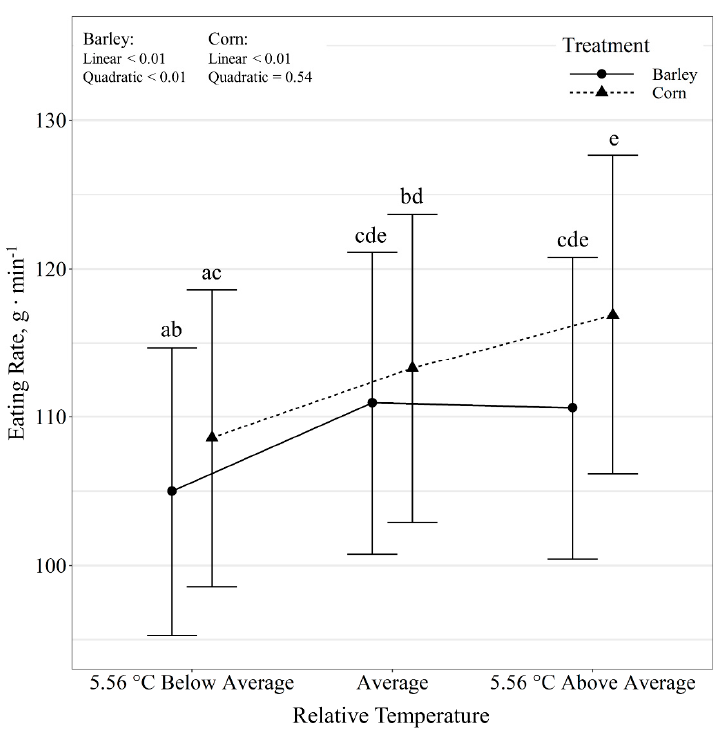
Figure 4. Influence of relative temperature change × diet ( p = 0.04) on eating rate (expressed as g min − 1 ) by beef steers consuming either barley or corn-based feedlot diets at the Northern Agricultural Research Center, Havre, MT, USA. Data points without a common letter differ ( p < 0.05). Diet had no effect ( p ≥ 0.12) on steer lying activity; however, temperature class influ- enced all lying activities ( p < 0.01). There was a quadratic effect ( p < 0.01) of relative tem- perature change on lying time per day, where, regardless of diet, lying time decreased ( p < 0.01) on days colder than the 10-day average but did not change ( p = 0.47) between days with average and warmer than the 10-day average temperature (Figure 5). Lying bouts per day was also quadratically influenced ( p < 0.01) by relative temperature change, where the number of lying bouts decreased ( p < 0.01) on days colder than the 10-day average but did not change ( p = 0.90) between days with average and warmer than the 10-day average